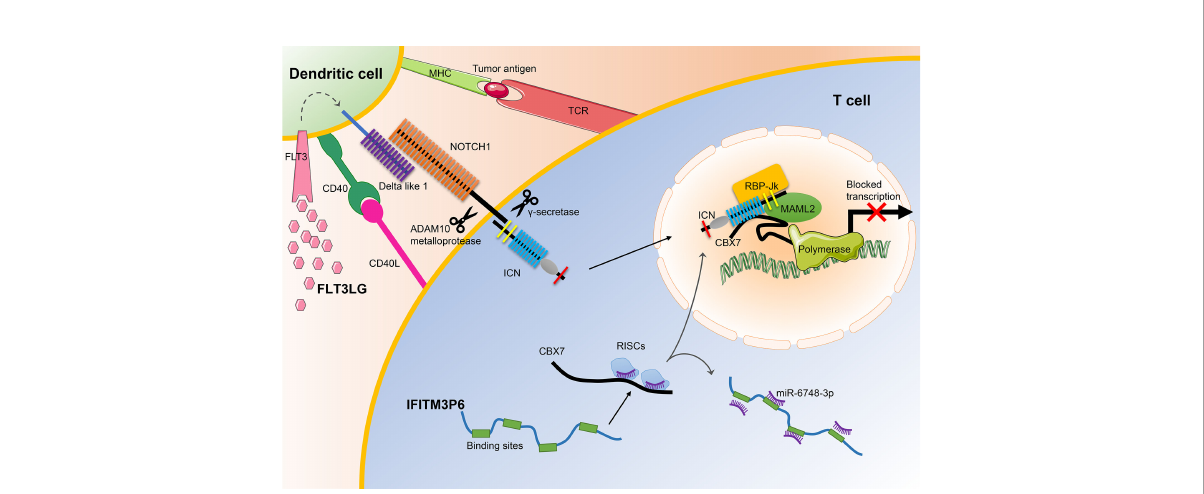
FIGURE 10 The main mechanisms of FLT3LG and IFITM3P6 in T cell activation. On the one hand, increased DLL1 by stimulation of FLT3LG to FLT3 in dendritic cells, transduct signals to NOTCH1 receptor expressed by T cells. Ligand/receptor binding triggers sequential proteolytic cleavage of NOTCH receptor, fi rst by the ADAM10 metalloprotease and by the g -secretase complex. These cleavages release intracellular NOTCH (ICN) into the nucleus. On the other hand, IFITM3P6 as a kind of ceRNA inhibit targeted degradation of CBX7 by miR-6748-3p. They fi nally promote the formation of NOTCH1-MAML2-CBX7 complex system, and suppress expression of